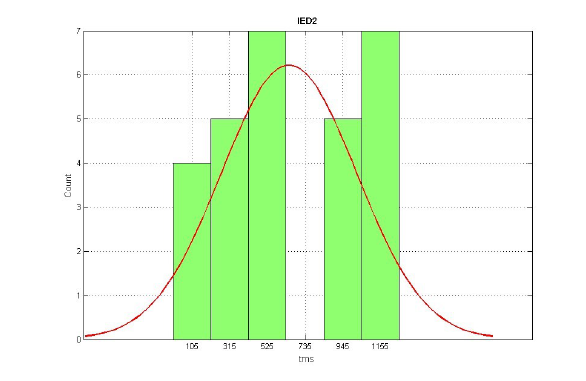
Figure 7: Histogram for the DPST.ECPConn based IED1-IED2 round trip time